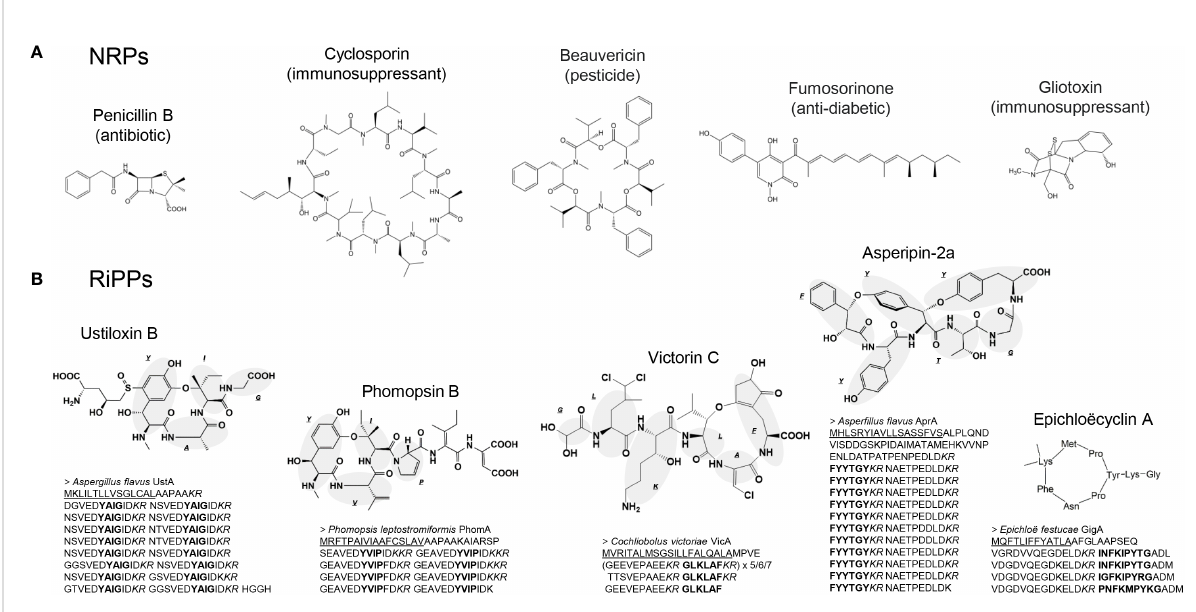
FIGURE 1 Examples of (A) nonribosomal peptides (NRPs) and (B) ribosomally synthesized and post-translationally modi fi ed peptides (RiPPs) produced by fi lamentous fungi. In (A) , the major known bioactivities are described for each compound. In (B) , the precursor protein sequences are shown below the corresponding compounds, where the endoplasmic reticulum signal peptide, core peptides, and Kex2 cleavage sites are underlined, bolded, and italicized,